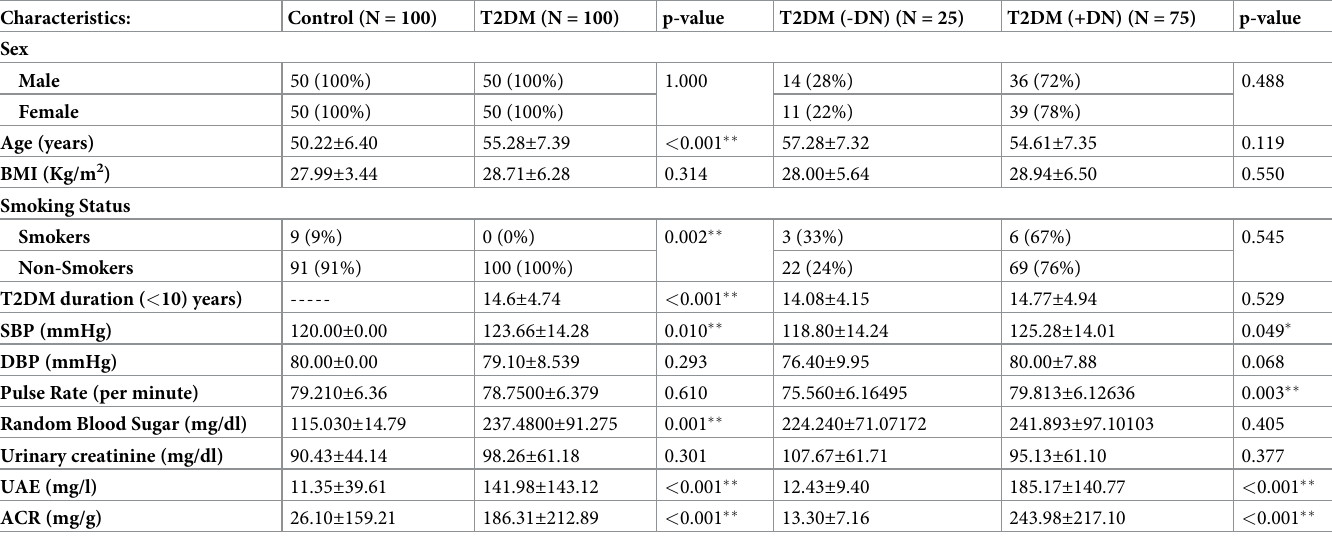
Data is given as Mean ± SD. BMI; body mass index, SBP; systolic blood pressure, DBP; diastolic blood pressure, UAE; urinary albumin excretion, ACR; Albumin to creatinine ratio, T2DM; type 2 diabetes mellitus, T2DM-DN; type 2 diabetes mellitus without nephropathy, T2DM+DN; type 2 diabetes mellitus with nephropathy. � significant at the level of 0.05 and �� highly significant at the level of